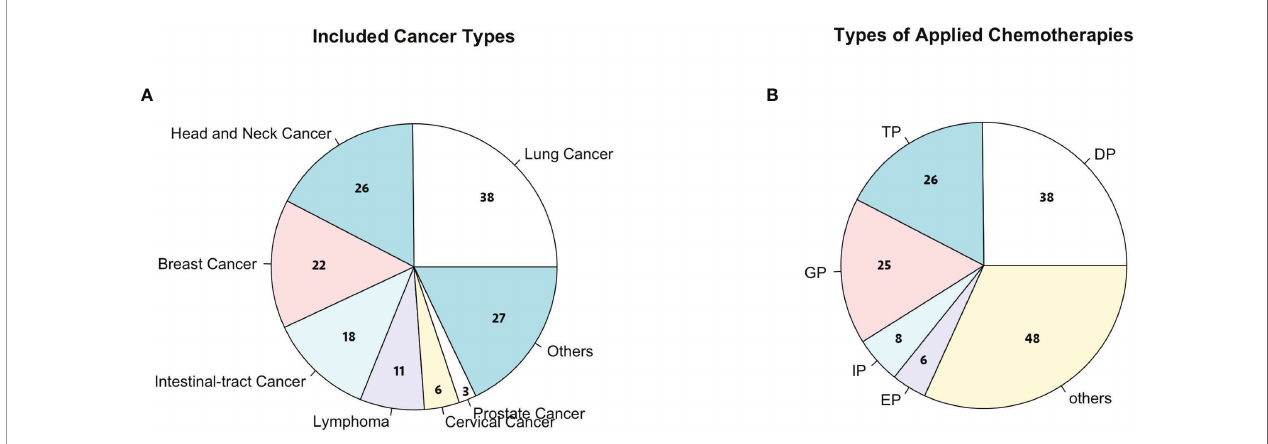
FIGURE 2 | (A) Cancer types considered in this study; others include colorectal cancer, bladder cancer, ureter cancer, liver cancer, and gastric cancer. (B) Chemotherapies considered in this study; others include TP (paclitaxel + cisplatin), DP (docetaxel + cisplatin), GP (gemcitabine + cisplatin), IP (irinotecan + cisplatin), EP (etoposide + cisplatin), and FOLFOX (oxaliplatin + calcium folinate + 5- fl